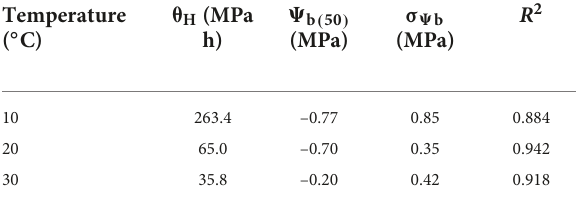
TABLE 2 Model parameters for the hydrotime model describing germination of Parthenium hysterophorus at different temperatures. Temperature ( ◦ C)